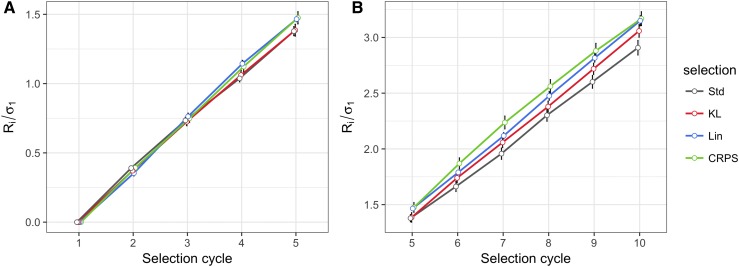
Results of the univariate simulation study. Standardized selection responses Ri/σ1=(μi−μ1)/σ1 for breeding cycles 1 to 5 are illustrated in A), while in B) are cycles 5 to 10. In each selection cycle, the top 30% with minimum posterior expected losses were selected using the Kullback-Leibler loss function (KL), the Continuous Ranked Probability Score (CRPS), the Linear-Linear loss function (LinLin), and the standard method (Std). Selected lines were crossed at each cycle to recover the population size for upcoming selection cycles. μi and Ri correspond to the population mean and the selection response, respectively, in cycle i; μ1 and σ1 are the population mean and the population standard deviation, respectively, in cycle 1. The black vertical lines indicate the standard error of Ri/σ1 under 20 replications of the simulation study.